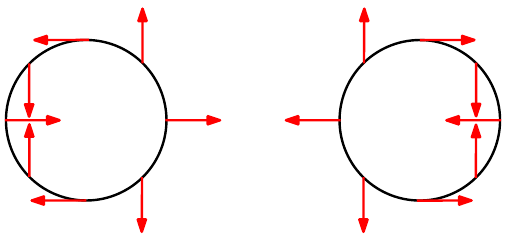
Figure 3. Behavior of the spin-orbit-parity pseudospin around the origin of momentum. As the polar angle φ Q varies from 0 to 2 π , the pseudospin σ of the states orientation is coupled to that of the total exciton